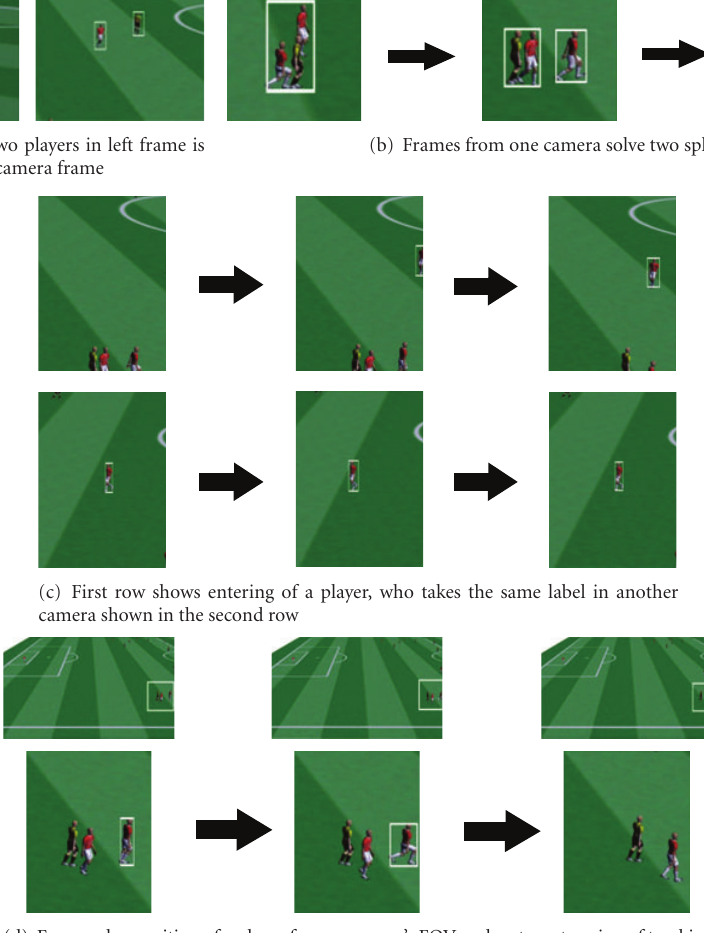
Figure 16: Four cases show the robust of the tracking algorithm in solving some of tracking